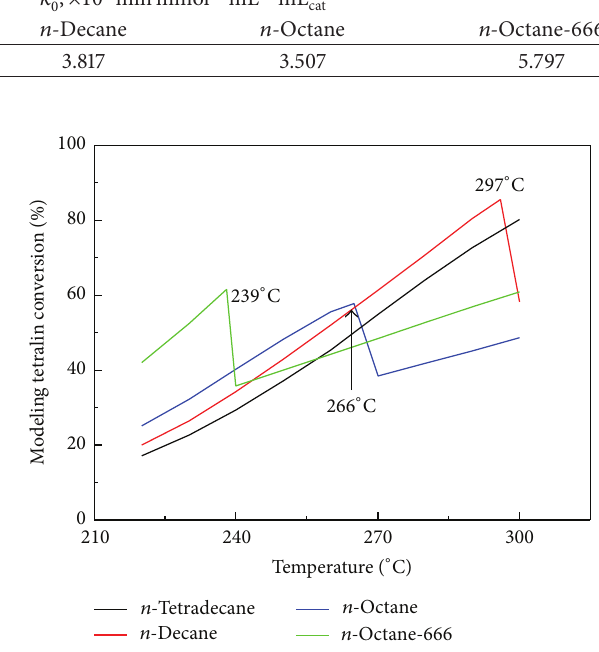
Figure 7: The tetralin conversion calculated by (4) and (5). Table 3: Tetralin conversion after gas-liquid-solid or gas-solid reaction manner,